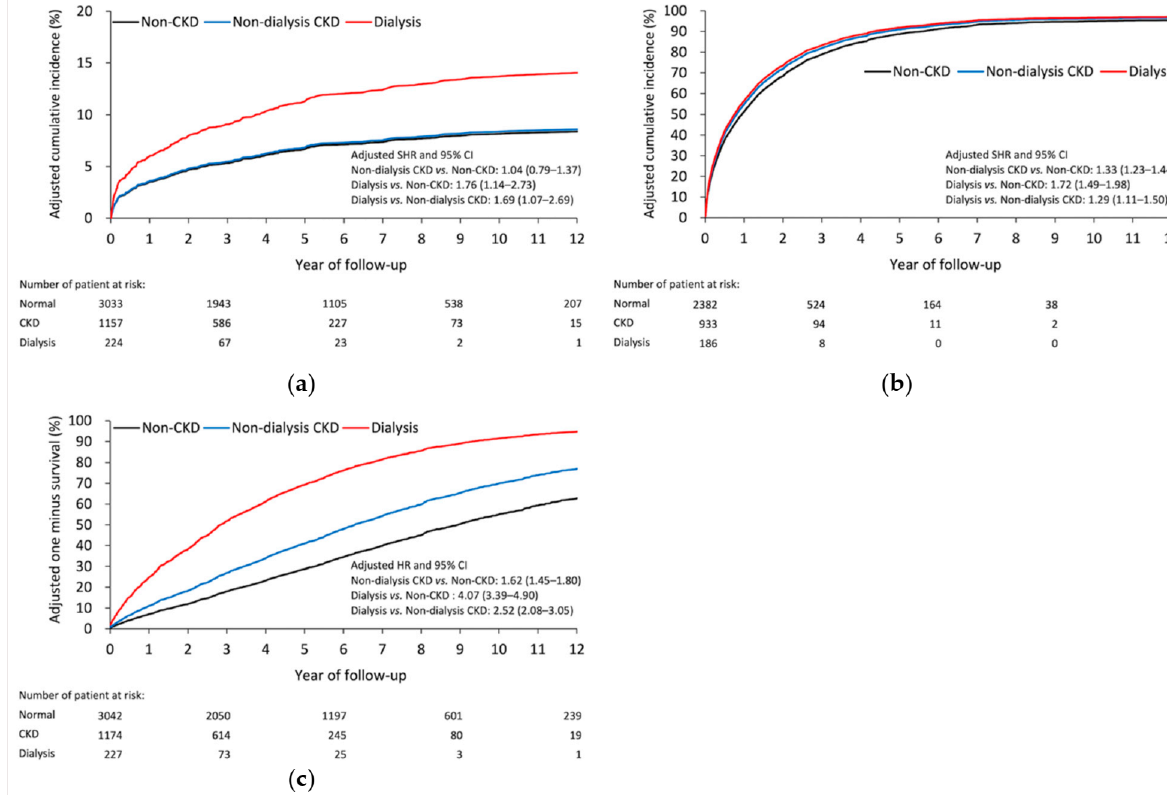
Figure 3. Adjusted cumulative incidence of ( a ) postoperative infection and ( b ) all-cause readmission. ( c ) Adjusted survival rate of all-cause mortality in patients with diabetes having different renal function statuses. CKD, chronic kidney